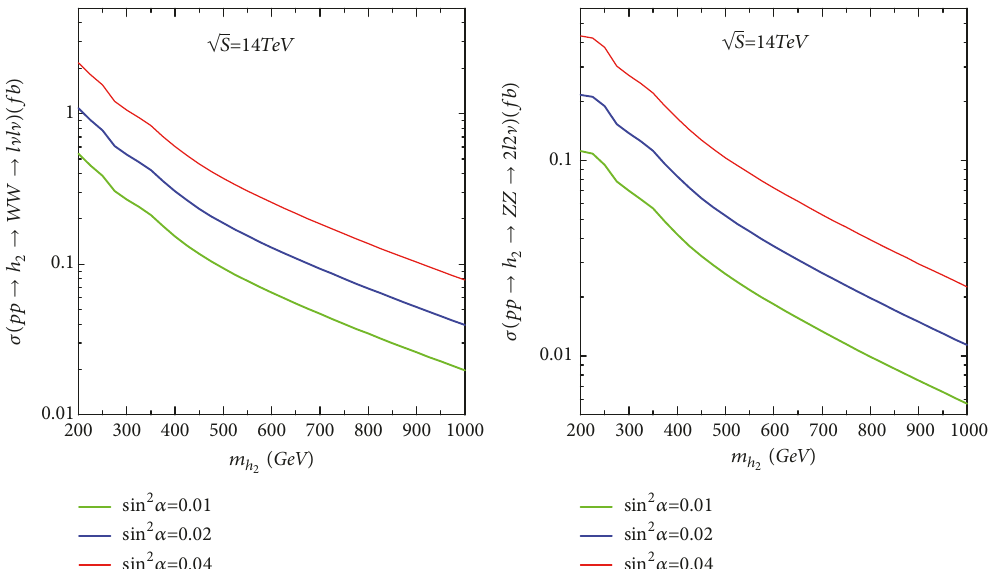
Figure 1: Production cross section 𝜎(𝑝𝑝 󳨀→ ℎ 2 + 𝑋) × Br (ℎ 2 󳨀→ 𝑊𝑊 󳨀→ 𝑙 ] 𝑙 ] ) (left) and 𝜎(𝑝𝑝 󳨀→ ℎ 2 + 𝑋) × Br (ℎ 2 󳨀→ 𝑍𝑍 󳨀→ 2𝑙2 ] ) (right) as function of 𝑚 ℎ for different strengths of mixing effect sin 2 𝛼 = 0.01 (green), 0.02 (blue), and 0.04 (red), respectively. 2